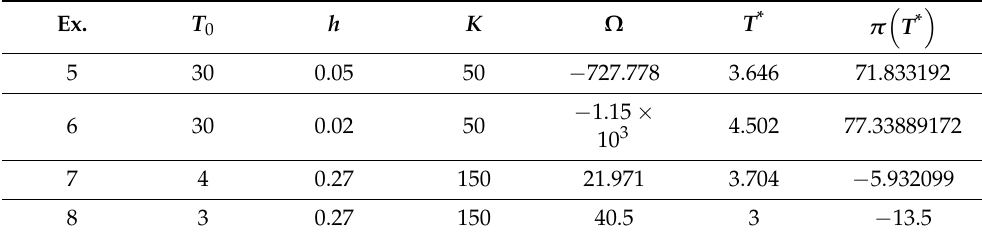
Table 7. Modified parameters for Examples 5–8 and optimal